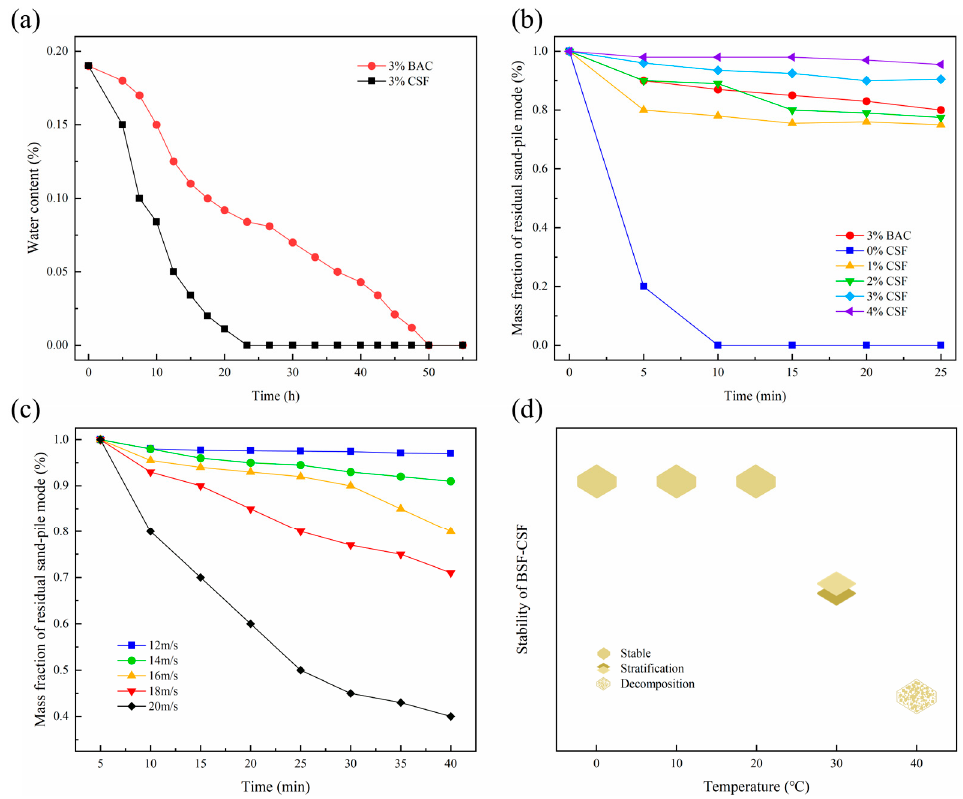
Figure 2. Application performance: ( a ) water retention experiment; ( b ) anti-water erosion experiment; ( c ) anti-wind erosion experiment; and ( d ) stability experiment of BAC.